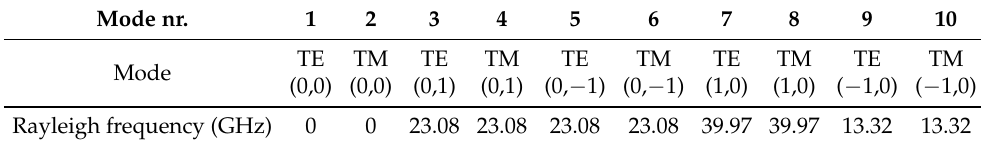
Table 2. Mode numbering for incidence at θ = 30 ◦ ( φ = 0) and corresponding Rayleigh frequencies. Mode